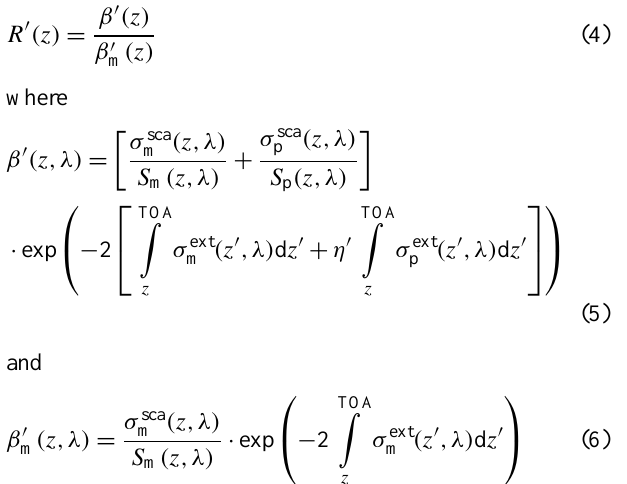
Fig. 2. Black carbon (BCAR) and mineral dust (DUST) extinction ( Q ext ) and scattering ( Q sca ) efficiencies as a function of size (radius) for 2 different wavelengths ( λ =532 , 1064 nm ).